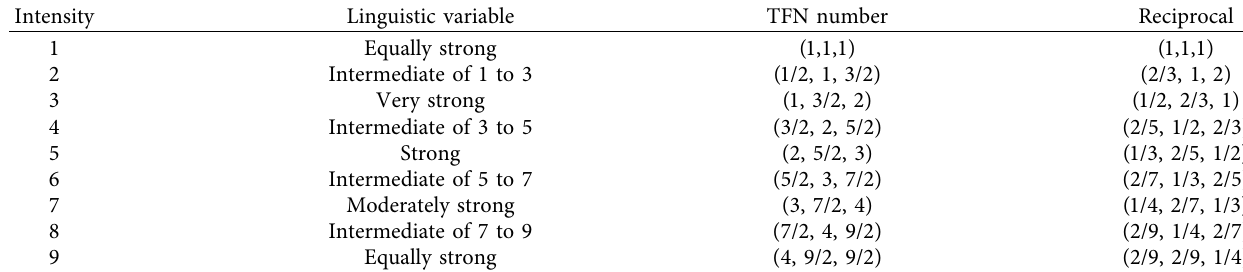
Table 2: TFN table [20, 26].